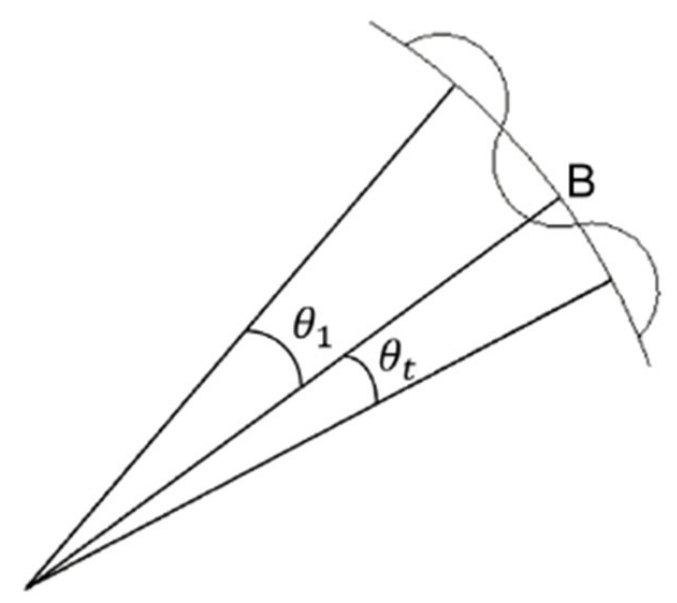
Figure 6. Teeth in Section B. Third, design the circular spline with number of lobes Z c and module m t . Figure 7 illustrates the process of designing a harmonic drive with the desired reduc- tion gear ratio and